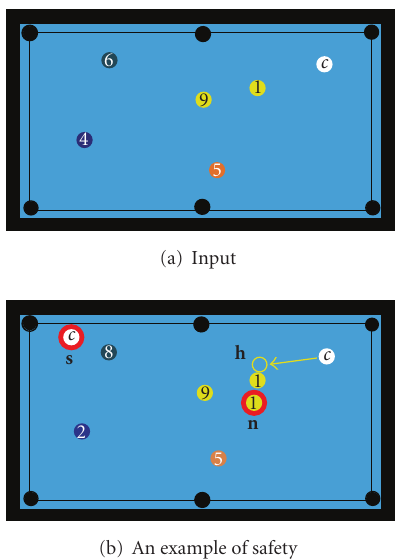
Figure 22: Ball arrangement for